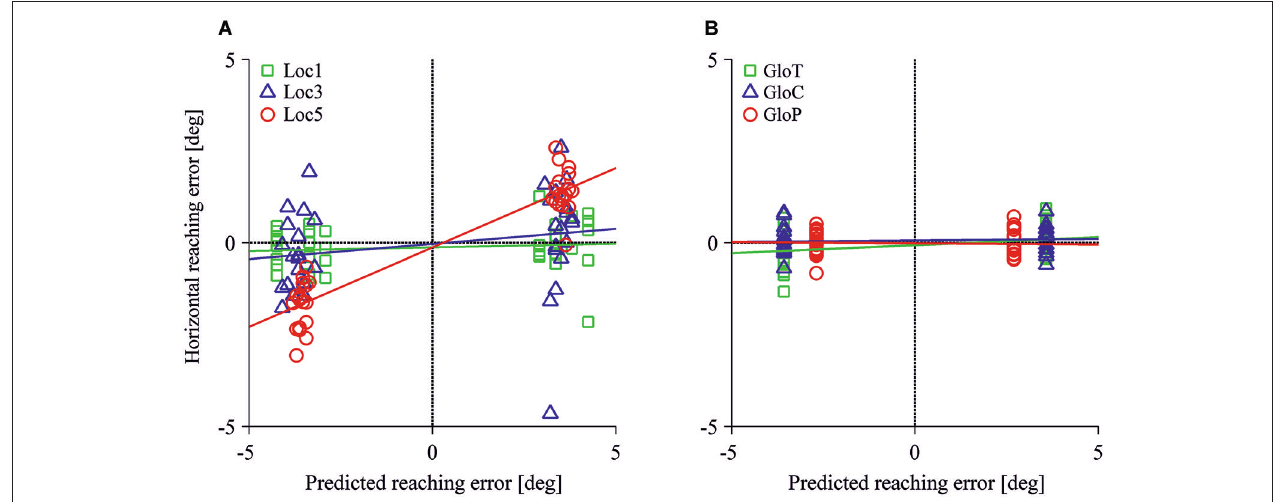
FIGURE 5 | Horizontal reaching errors as a function of predicted allocentric reaching errors for the local (A) and the global conditions (B) . Each symbol specifies mean reach endpoints for one test image. Colored lines represent regression fits for each allocentric condition.